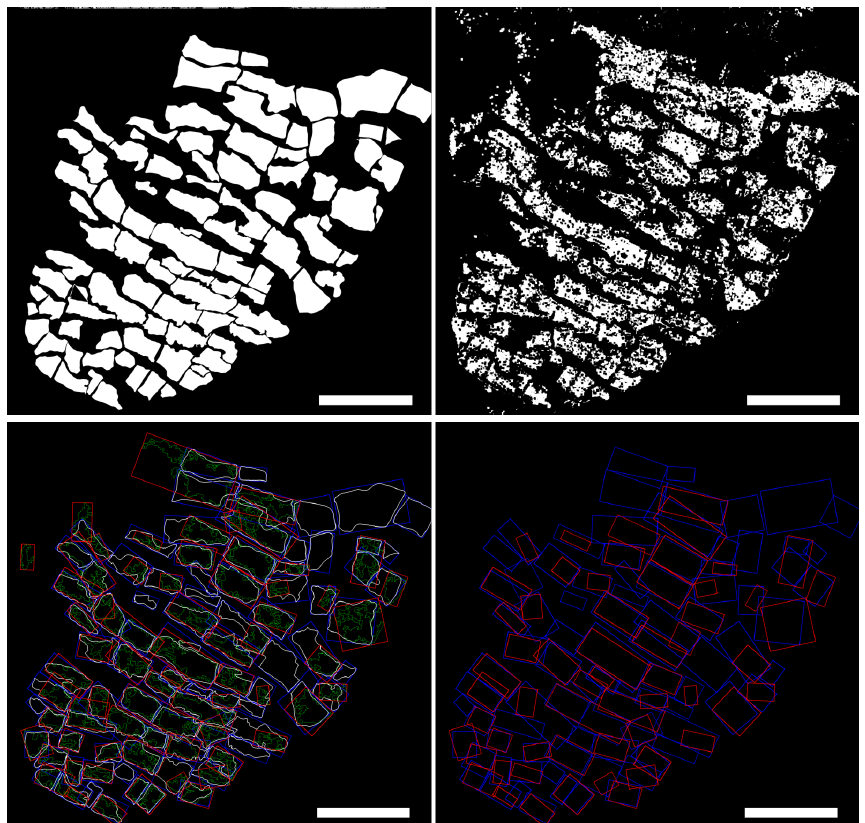
Figure 6. Manual versus automatic cell delineation in image a . Top left: mask M m obtained by manual delineation of CMs’ boundaries in image a . Top right: mask M a generated by Myocyte Automatic Retrieval and Tissue Analyzer (MARTA) software for image a . Bottom left: CMs’ contours for manual (white) and automatic (green) masks and corresponding enclosing rectangles (blue for manual, red for automatic). Bottom right: Enclosing rectangles from manual and automatic masks showing overlapping above 50%. Scale bar = 100 µ m.